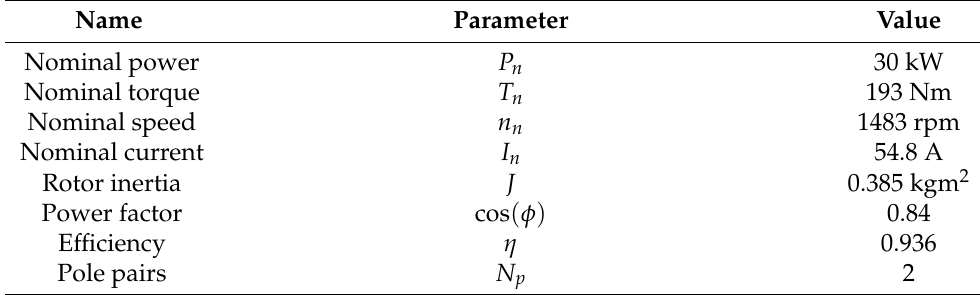
Table 7. Induction motor data ABB 3GBP202410 at 400 VAC 50